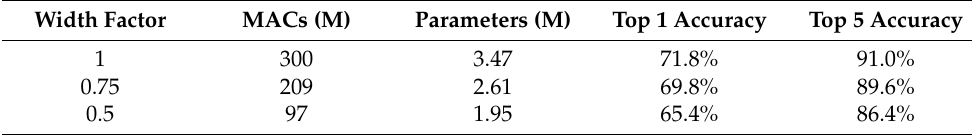
Table 2. Performance of MobileNetV2 under different width factors. MACs (M)